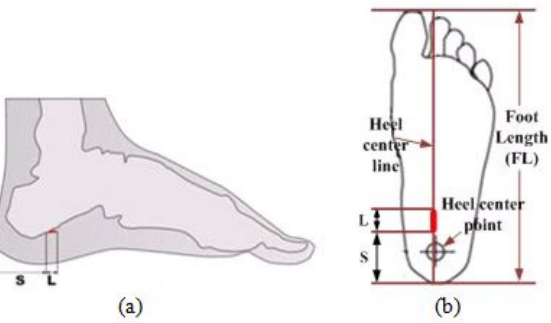
Figure 1. Determination of spur location and dimension in plantar view. Table 1. Subject characteristics.